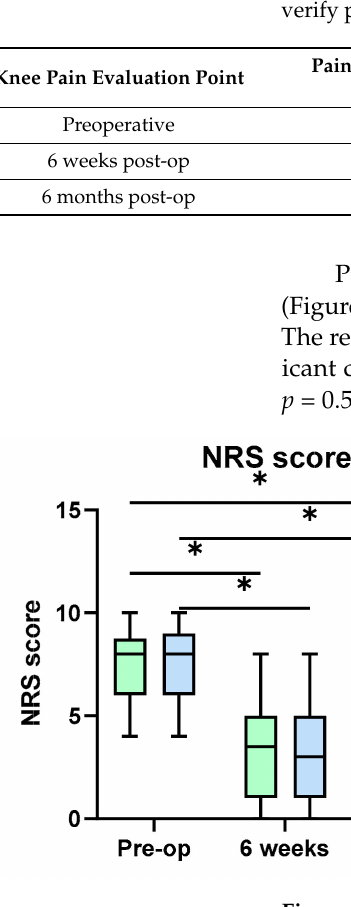
Figure 2. NRS scores and ROM in patients with resected (green) and retained (blue) IFP preoperatively, at 6 weeks and 6 months follow-up. Asterisks indicate statistically significant difference between values; ns—lack of